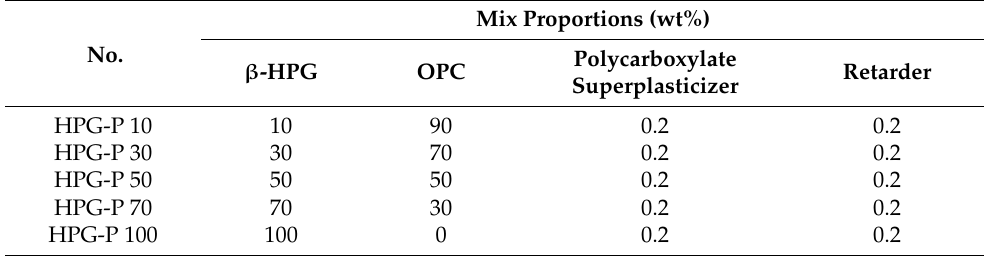
Table 3. The formulation of the HPG-P composites.